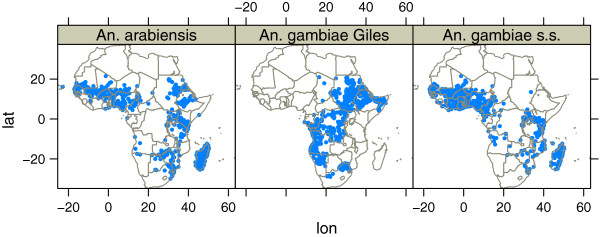
Presence points forAn. arabiensis,An. gambiae s.s. andAn. gambiae.